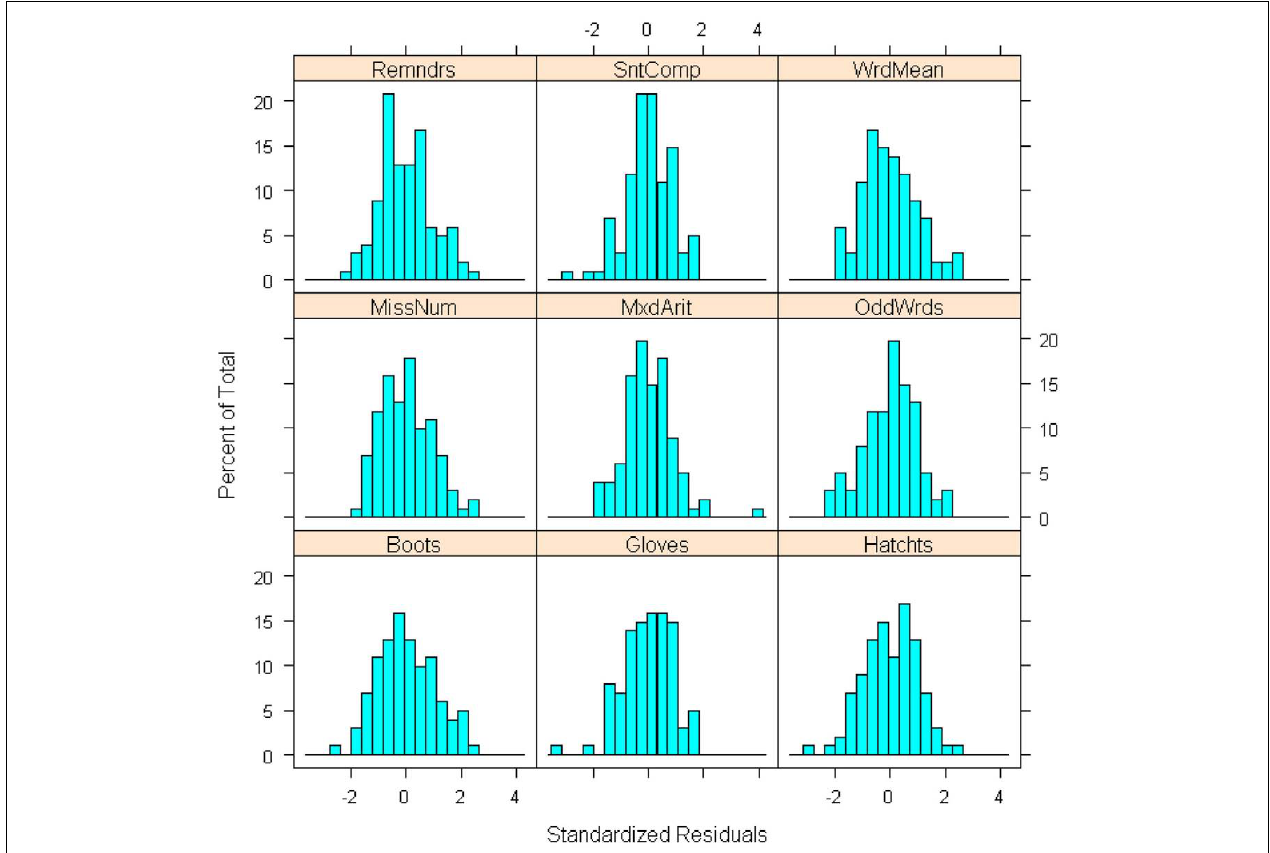
FIGURE 6 | Histograms of standardized residuals for each observed variable from three-factor model fitted to perturbed sample data ( N =